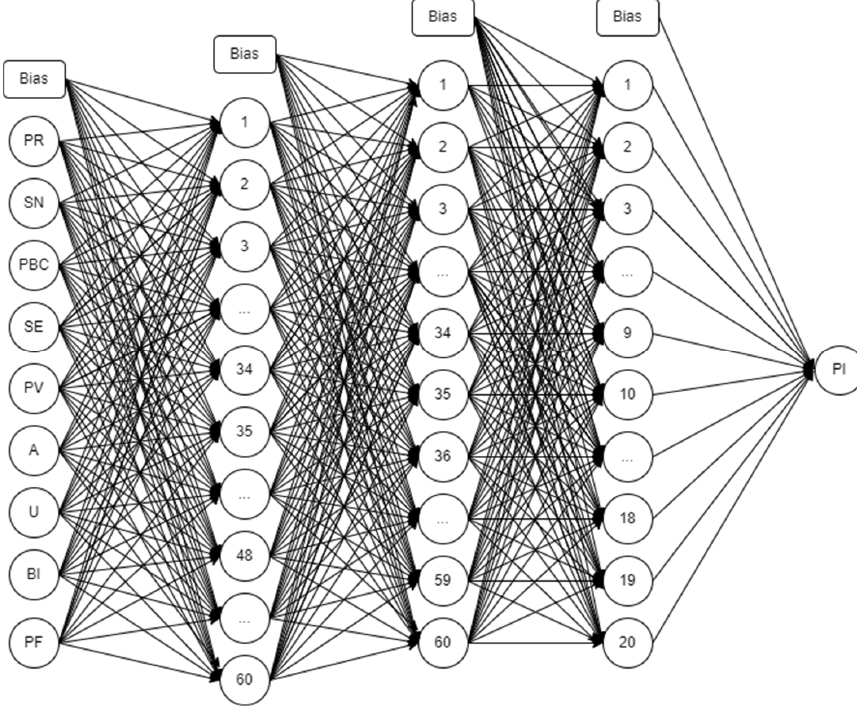
Figure 4. Deep Learning Neural Network Model.